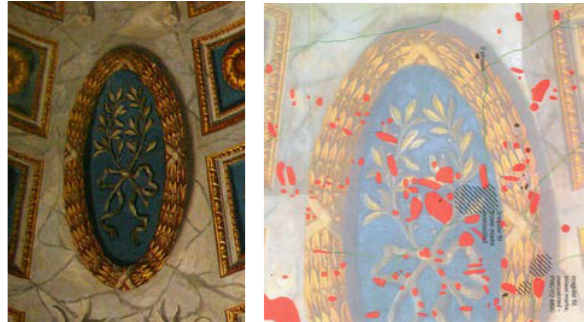
Figure 3. (left) Target area on ceiling; (right) locations of damage marked in red from previous survey in 2010.